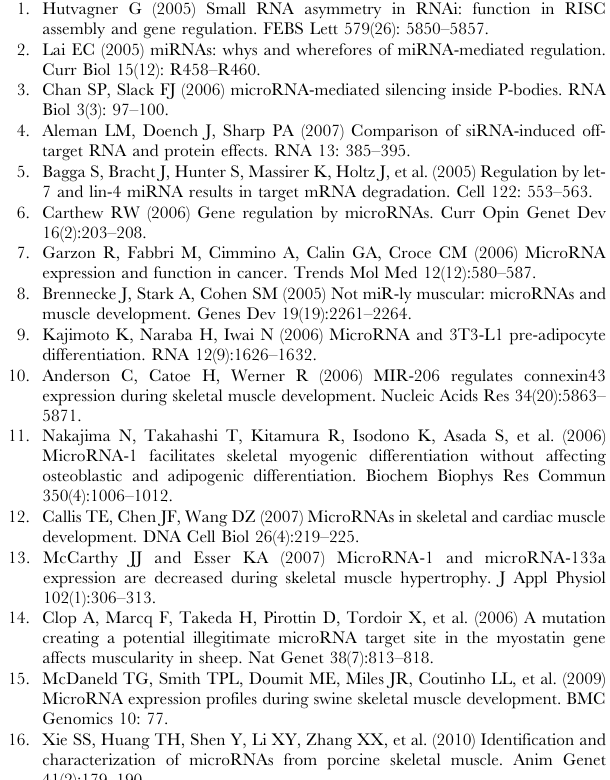
Table S1 MicroRNA sequence for highly abundant